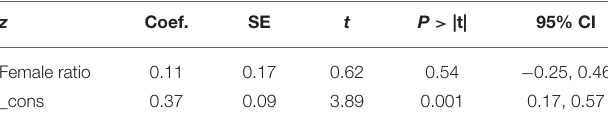
TABLE 4 | Univariate regression analysis of gender (random-effect model). z